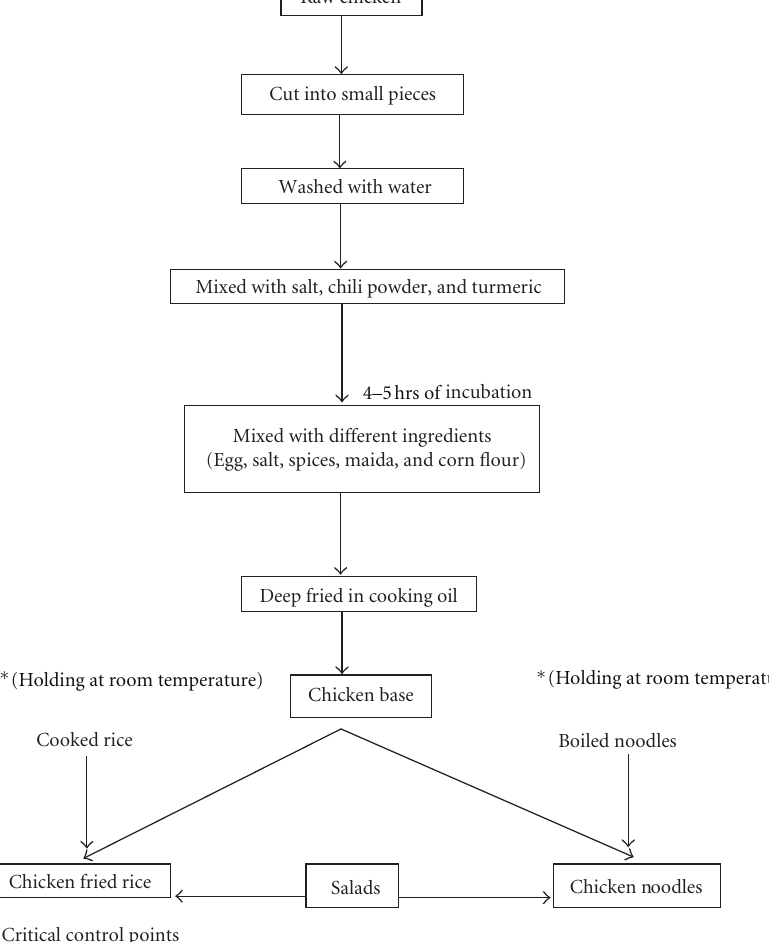
Figure 1: Flow chart to identify hazard analysis and critical control